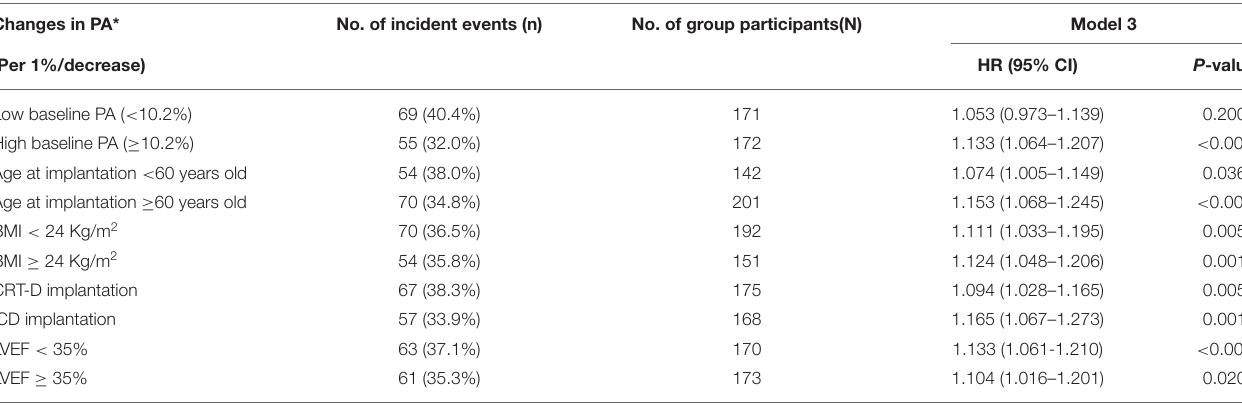
TABLE 3 | Subgroup analysis of new-onset AF based on different